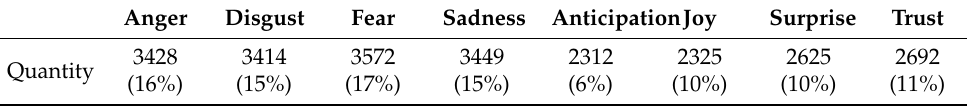
Table 3. Emotion words distribution of Emolex.